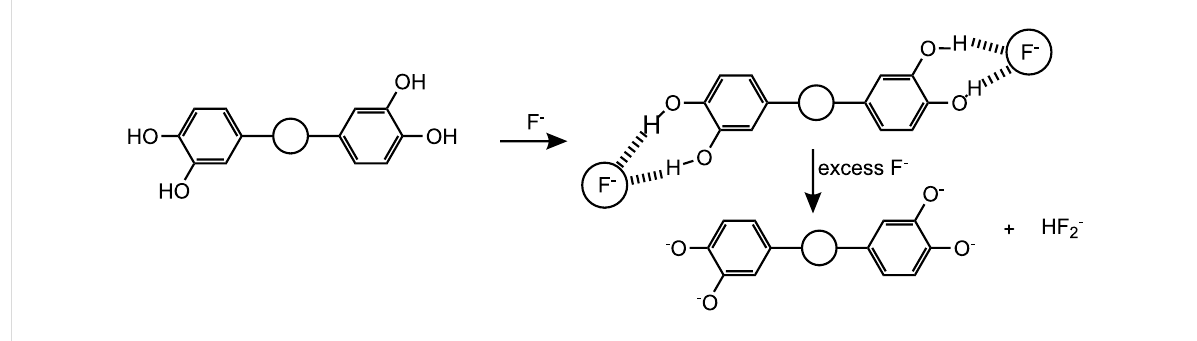
Scheme 2: Schematic representation (the circles represent the indolocarbazole moiety) of the two-step process leading to receptor deprotonation with basic fluoride anions.